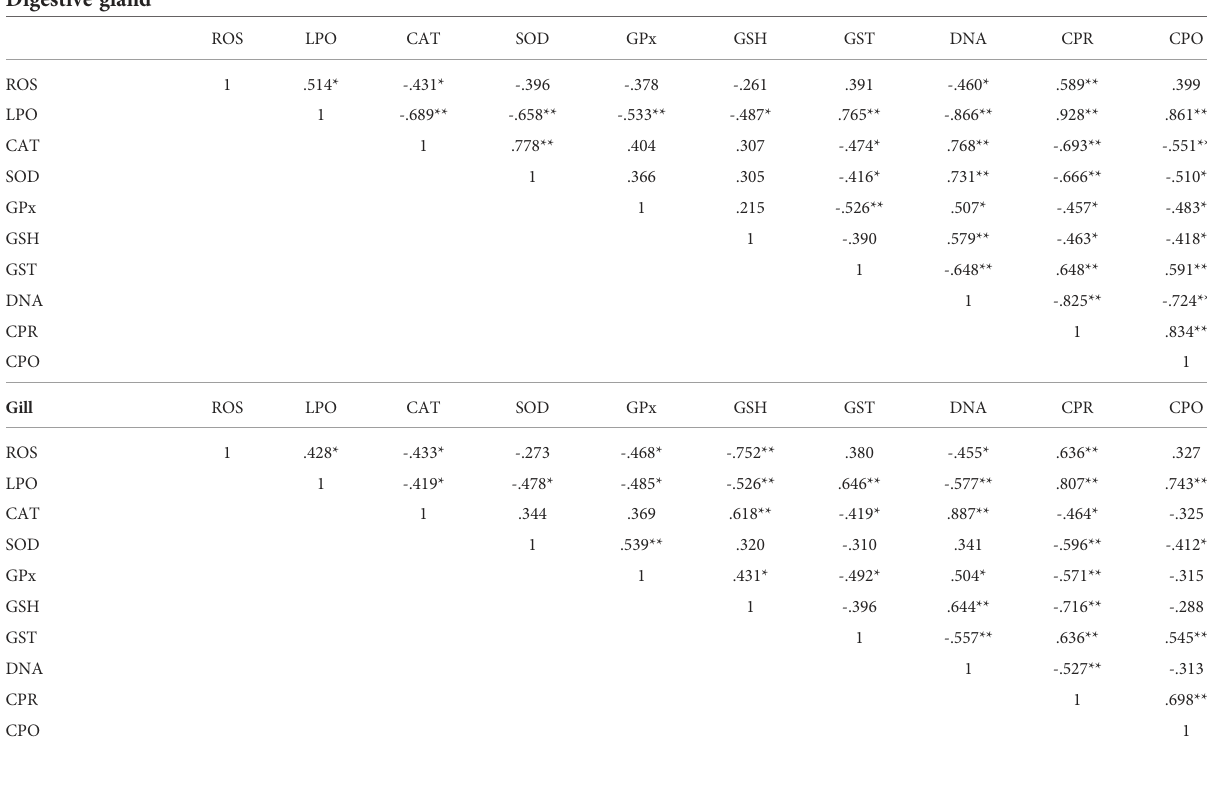
TABLE 1 Correlation Matrix for measured parameters in digestive gland and gill of Perna viridis exposed to different concentration of Naphthalene. Digestive